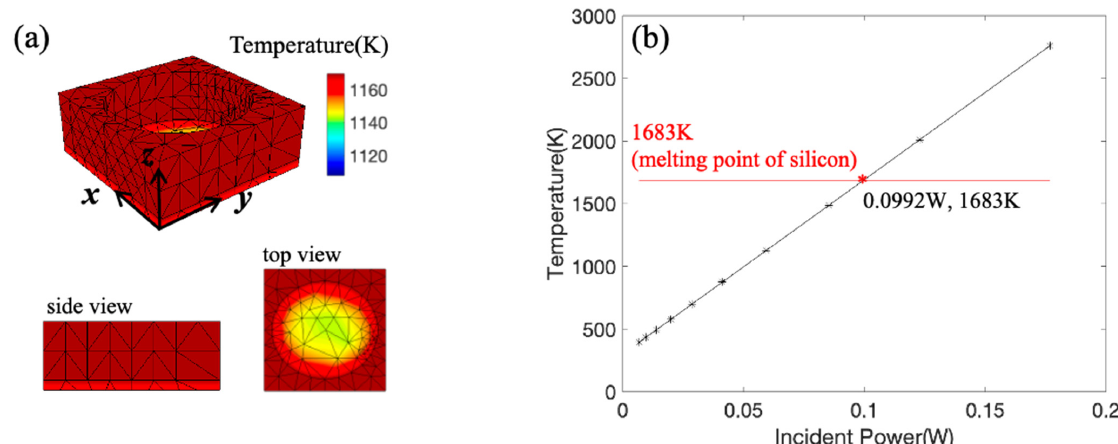
Figure 8. Photothermal analysis of the reflective meta-film: ( a ) the temperature distribution in the unit-cell (area: 0.36 µm 2 ) of the meta-film illustrated by a plane-wave laser with power 0.0625 W; ( b ) the maximum value of temperature in the 3D volume of the unit-cell ( a ) under the illumination of different incident powers. Here, the height H = 200 nm, D x = 0.485 µm, D y = 0.525 µm, and the lattice period P is 600 nm.